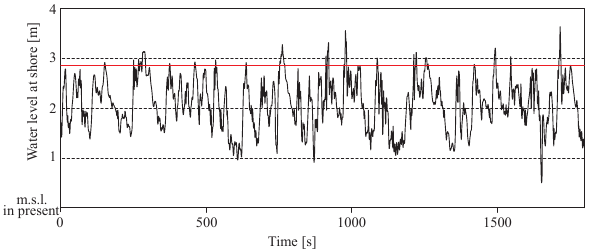
Figure 6. Effect of reef growth on change in the significant wave height at the reef flat for the TCs by 2100. Assumptions: 8.70– 11.0m SWH o ; 13.0–15.0s SWP o ; 0.24–0.98m SLR; 1.8m above present m.s.l. WL o (i.e., high tide and storm surge). The SLR val- ues are based on the values for the RCP scenario in 2100 (Church et al., 2013). The examples show that healthy reefs will reduce wave height.